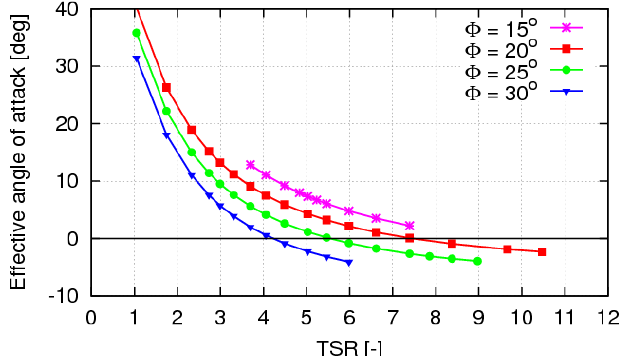
Figure 21. UoS-VP turbine. Effective angle of attack α e at radius r / R = 0.7 for different pitch settings and TSR